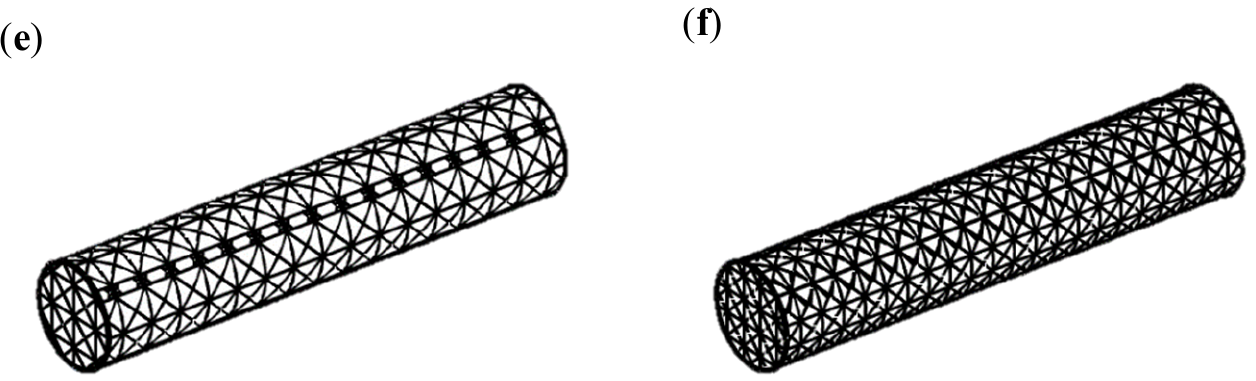
Figure 12. FCC net ( a ), no filter ( b ) and with filter applied ( c , d ), cube with lattice rotated 30 ◦ with unit cell sizes 12 and 9 ( e , f ), and cylinder with unit cell sizes 12 and 9.